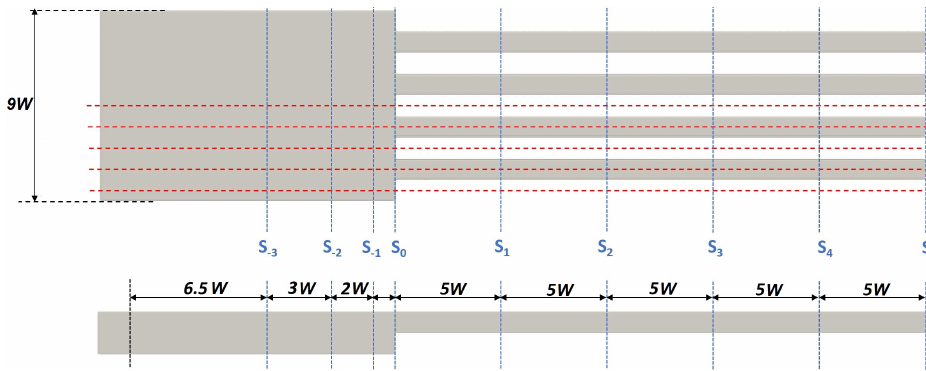
Figure 3. Location of transversal study planes S .